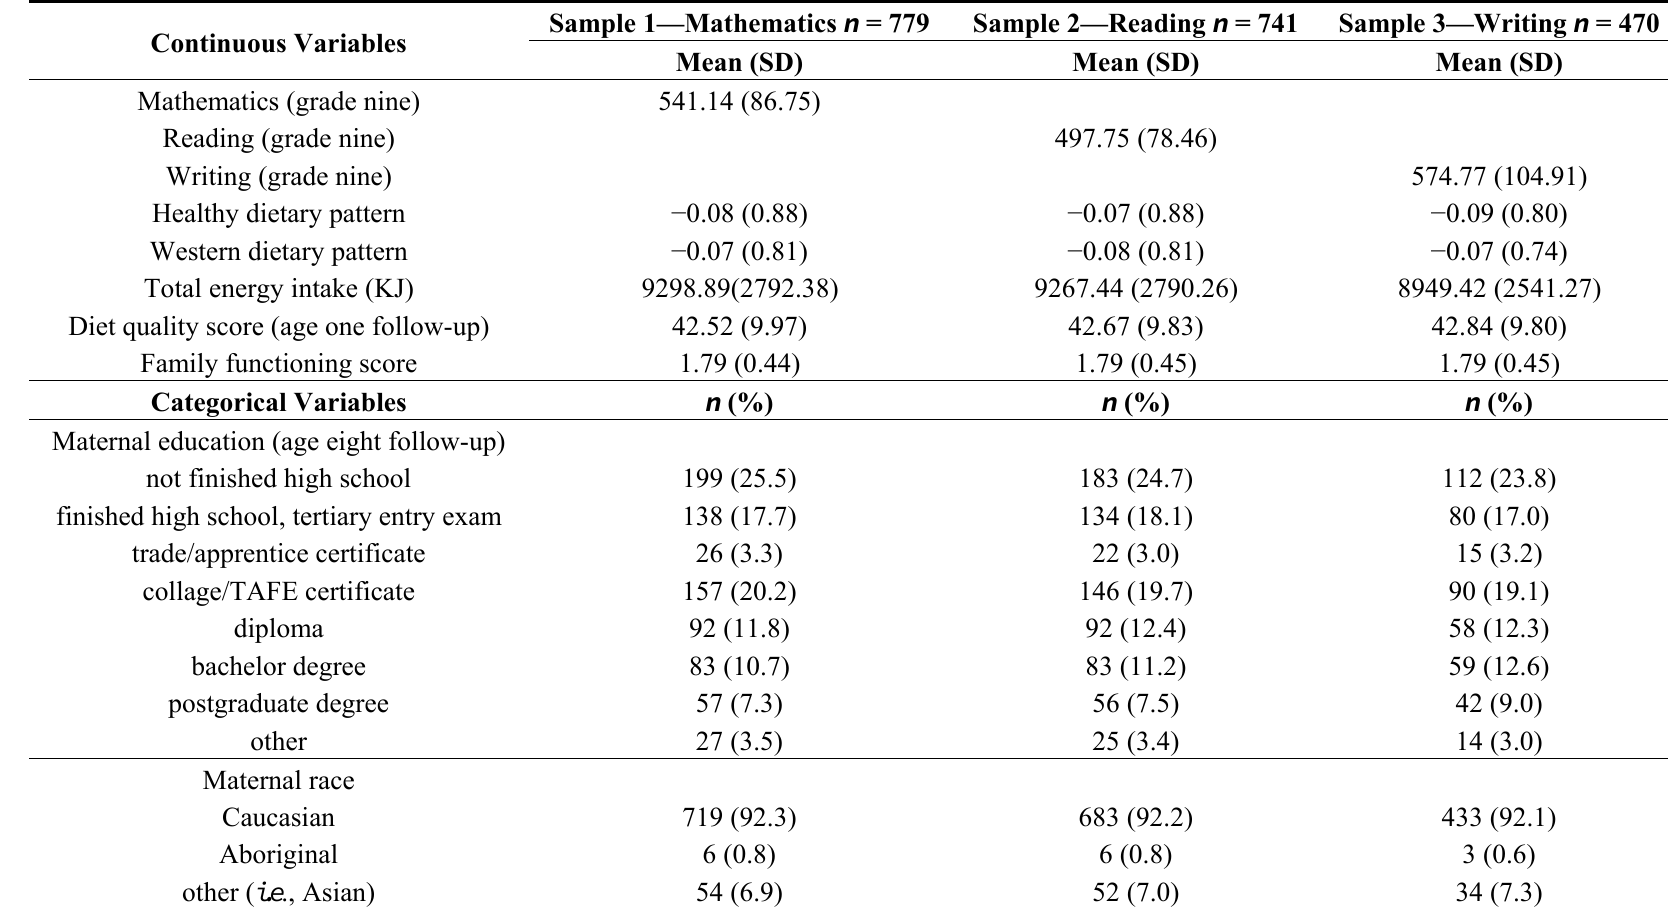
Table 1. Descriptive characteristics of the Western Australian Pregnancy Cohort (Raine) Study at age 14 by educational outcomes, mathematics, reading and writing at 14